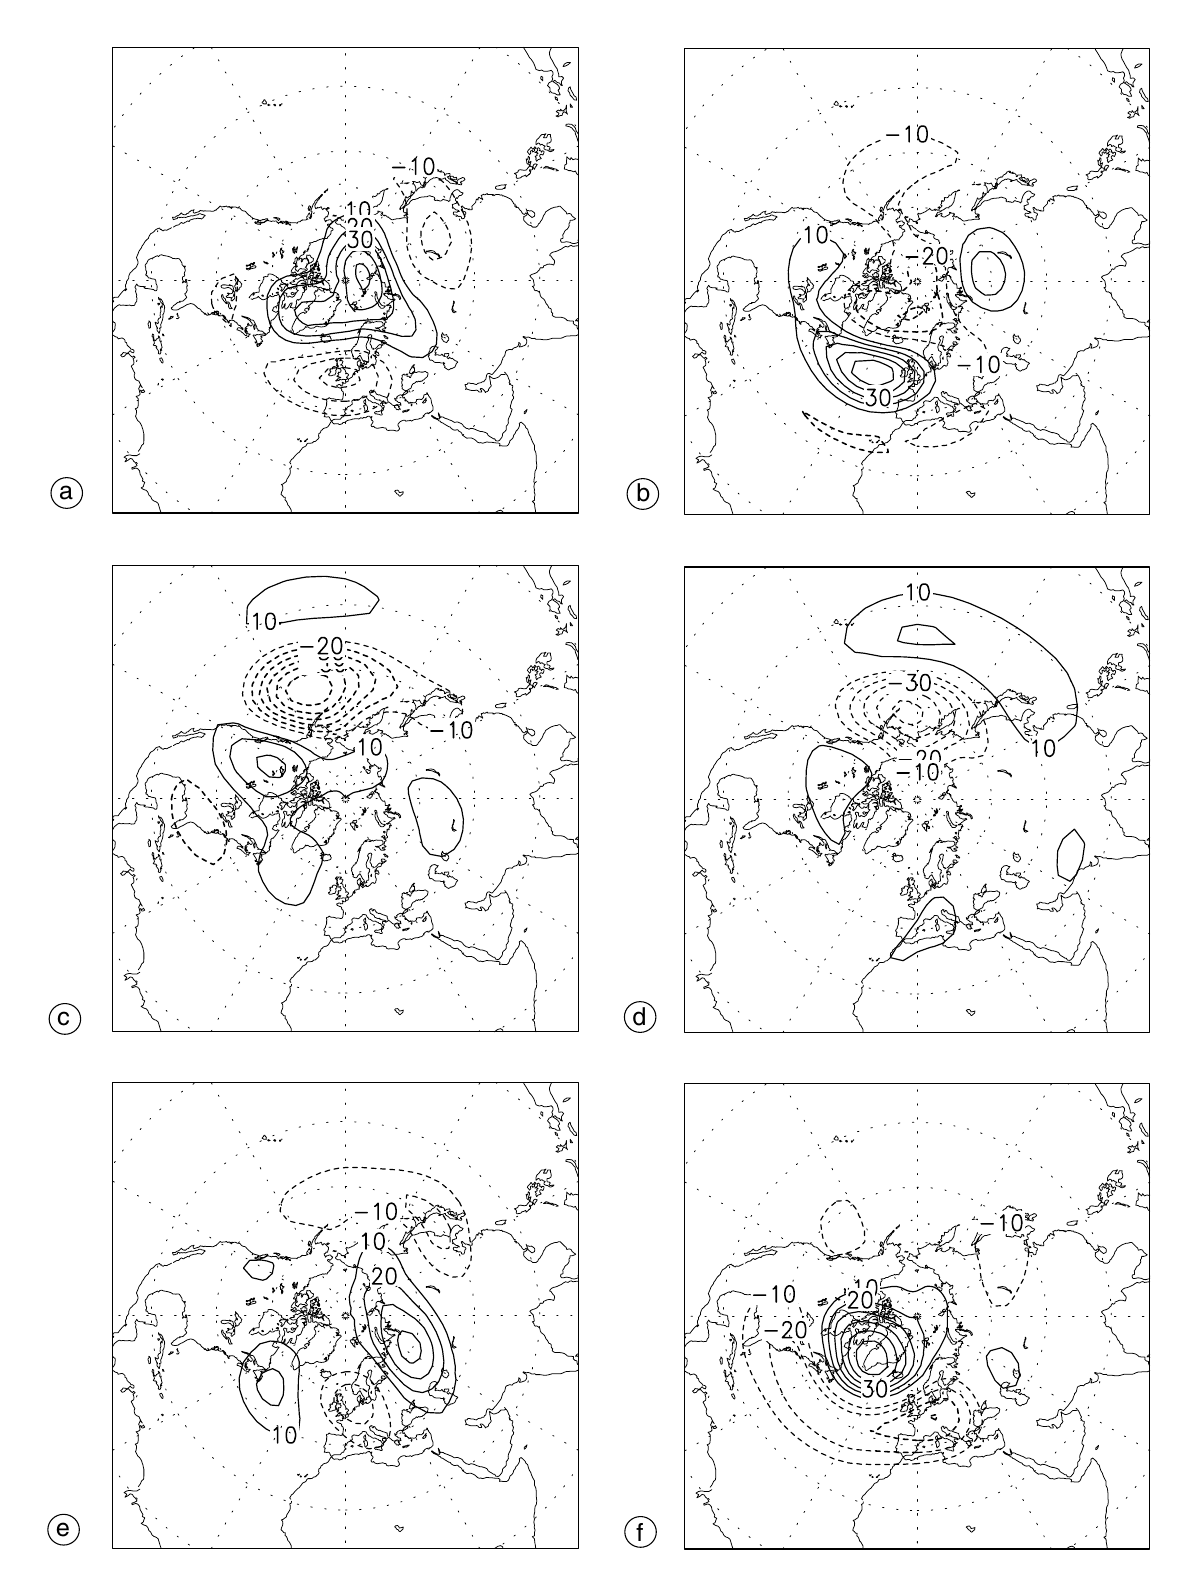
Fig. 7a-f. Projection of the common EOF structures (shown in fig. 6a-f) onto the NCEP reanalysis data set. Units are in